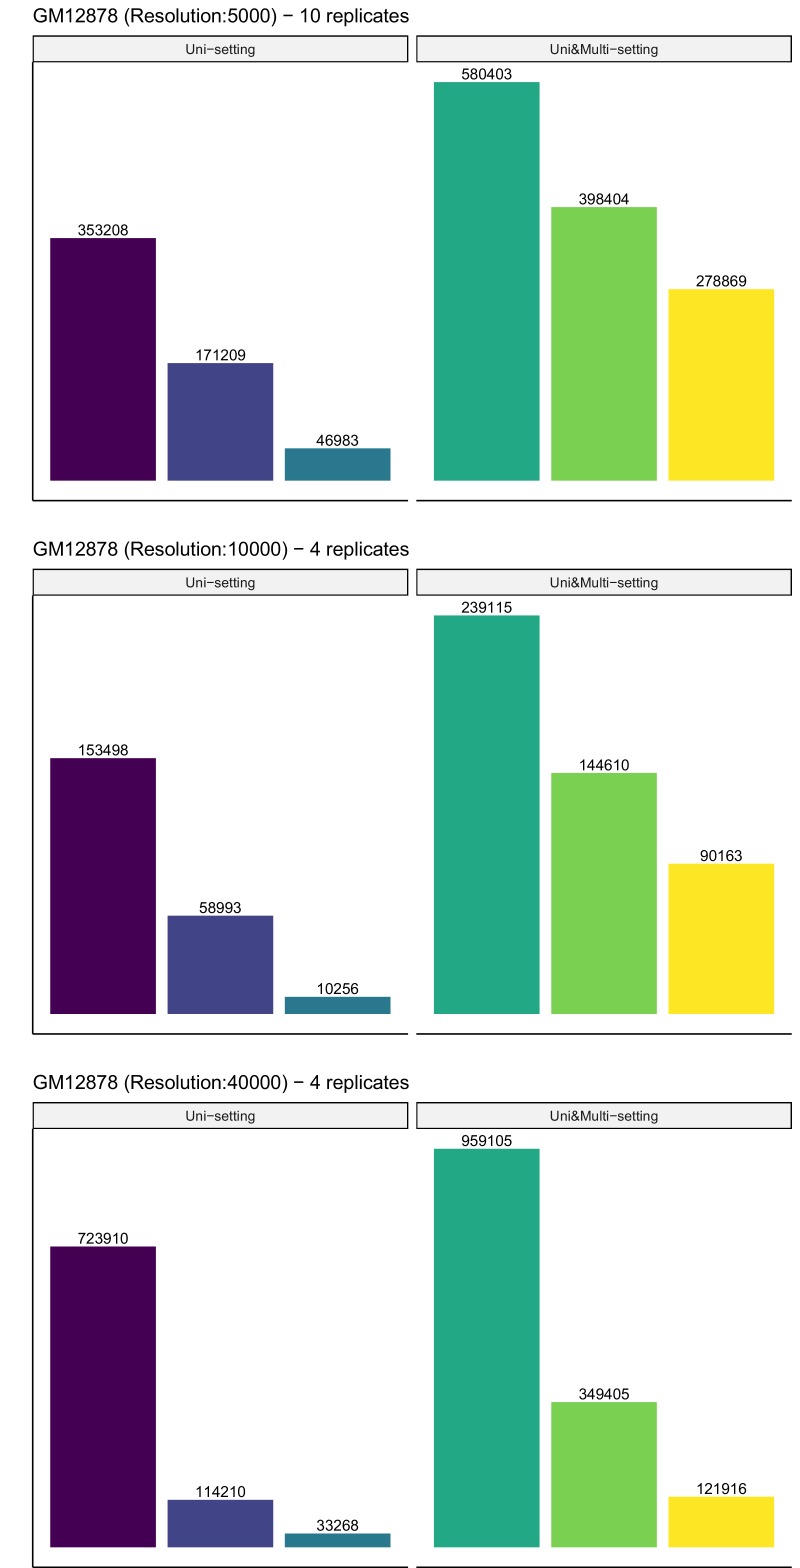
Recovery of significant interactions identified at FDR 1% by analysis at FDR 10% for GM12878 summed across replicates at 5 kb, 10 kb, and 40 kb resolutions.Color label is the same as Figure 3—figure supplement 8.